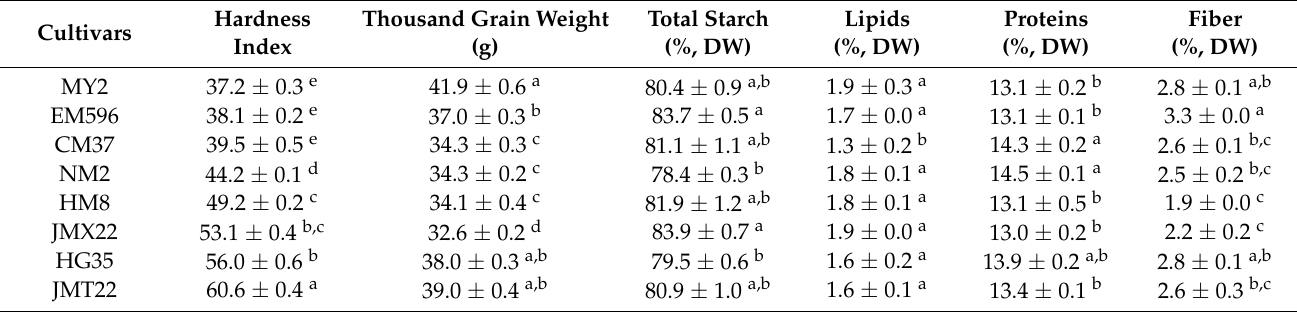
Table 1. Proximate composition of wheat grains varying in grain hardness.